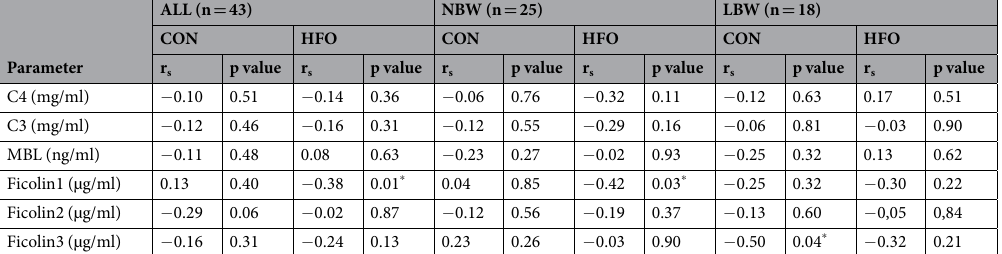
Table 4. Associations between M-value and serum levels of C4, C3 and lectin pathway initiators. Spearman’s correlations (r s ) between M-value (an inverse measure of insulin resistance) and serum levels of C4, C3 and lectin pathway initiators. Statistical significance assumed for values * P ≤ 0.05, ** P ≤ 0.01, *** P ≤ 0.001. CON, control diet; HFO, high-fat overfeeding; NBW, normal birth weight individuals; LBW, low birth weight individuals; ALL, NBW + LBW